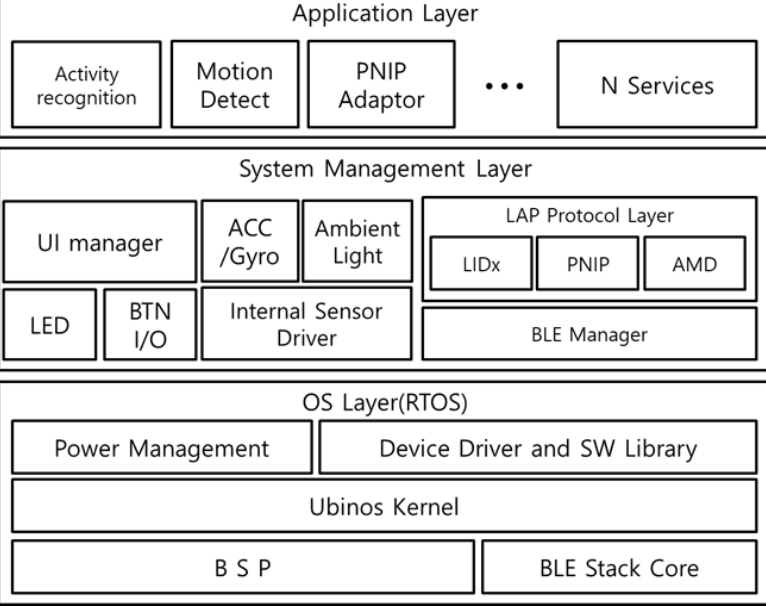
Figure 11. S/W Architecture of External Sensor